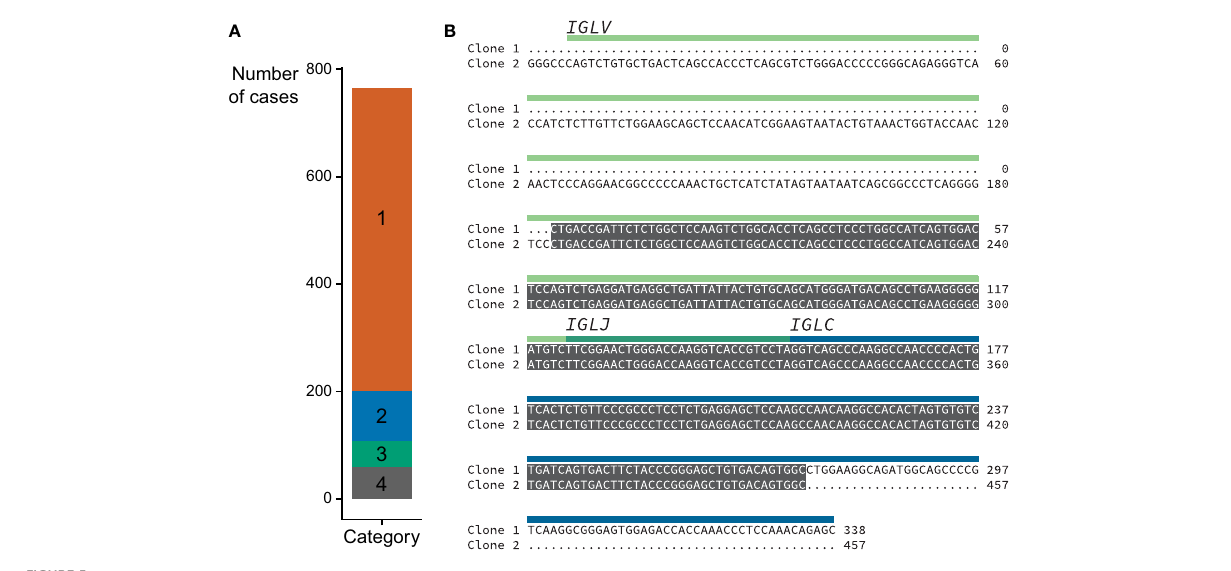
FIGURE 5 Locus and category assignment for 766 CoMMpass samples. (A) Sequences assigned to each category. Category colors are the same as in Figure 4. (B) Example Category 2 alignment comparing the top two clones identi fi ed by MiXCR within a single case (MMRF126178). The two clones are identical over a 254 nt region which includes CDR3, and were therefore collapsed to yield a single sequence. The regions corresponding to the precursor germline genes are shown with green and blue